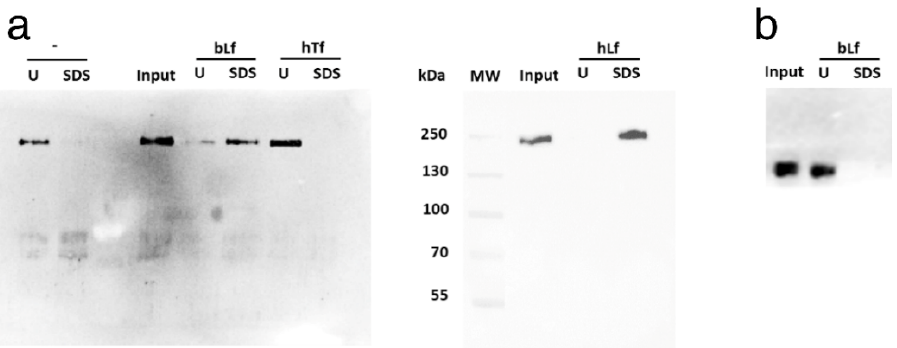
Figure 3. Sepharose 6B pull down of full-length stabilized trimeric ( a ) and S1 domain ( b ) SARS-CoV-2 Spike. Unconjugated (-), bovine Lactoferrin (bLf)-, human Lactoferrin (hLf)- and human Transferrin (hTf)-conjugated Sepharose 6B resins were employed. Input, unbound (U) and SDS eluted fractions were analysed through Western blot.